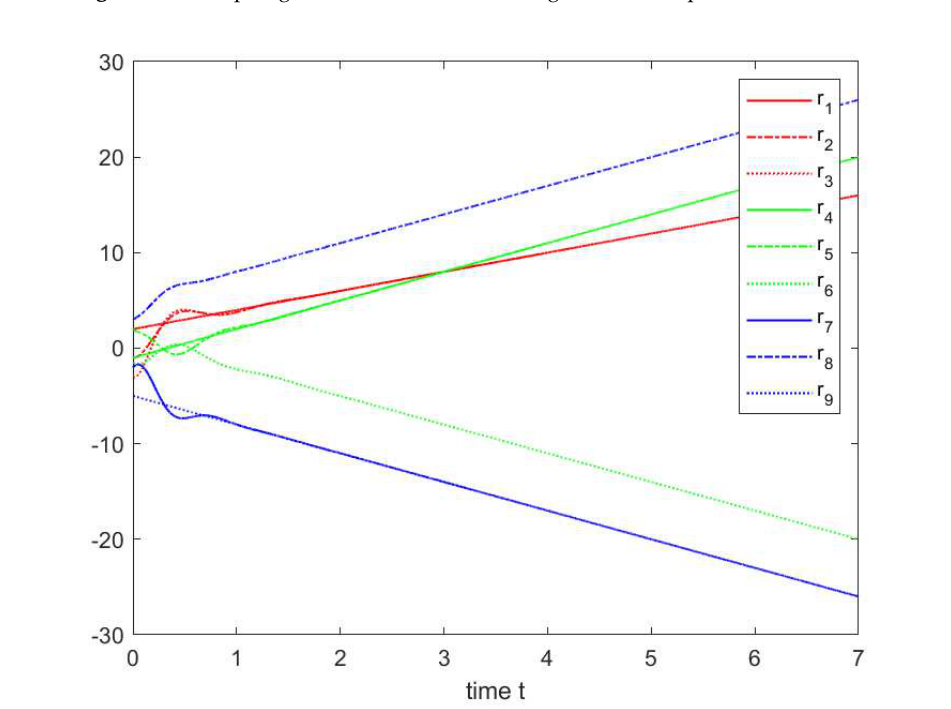
Figure 6. The topological structure of the nine agents in Example 2.